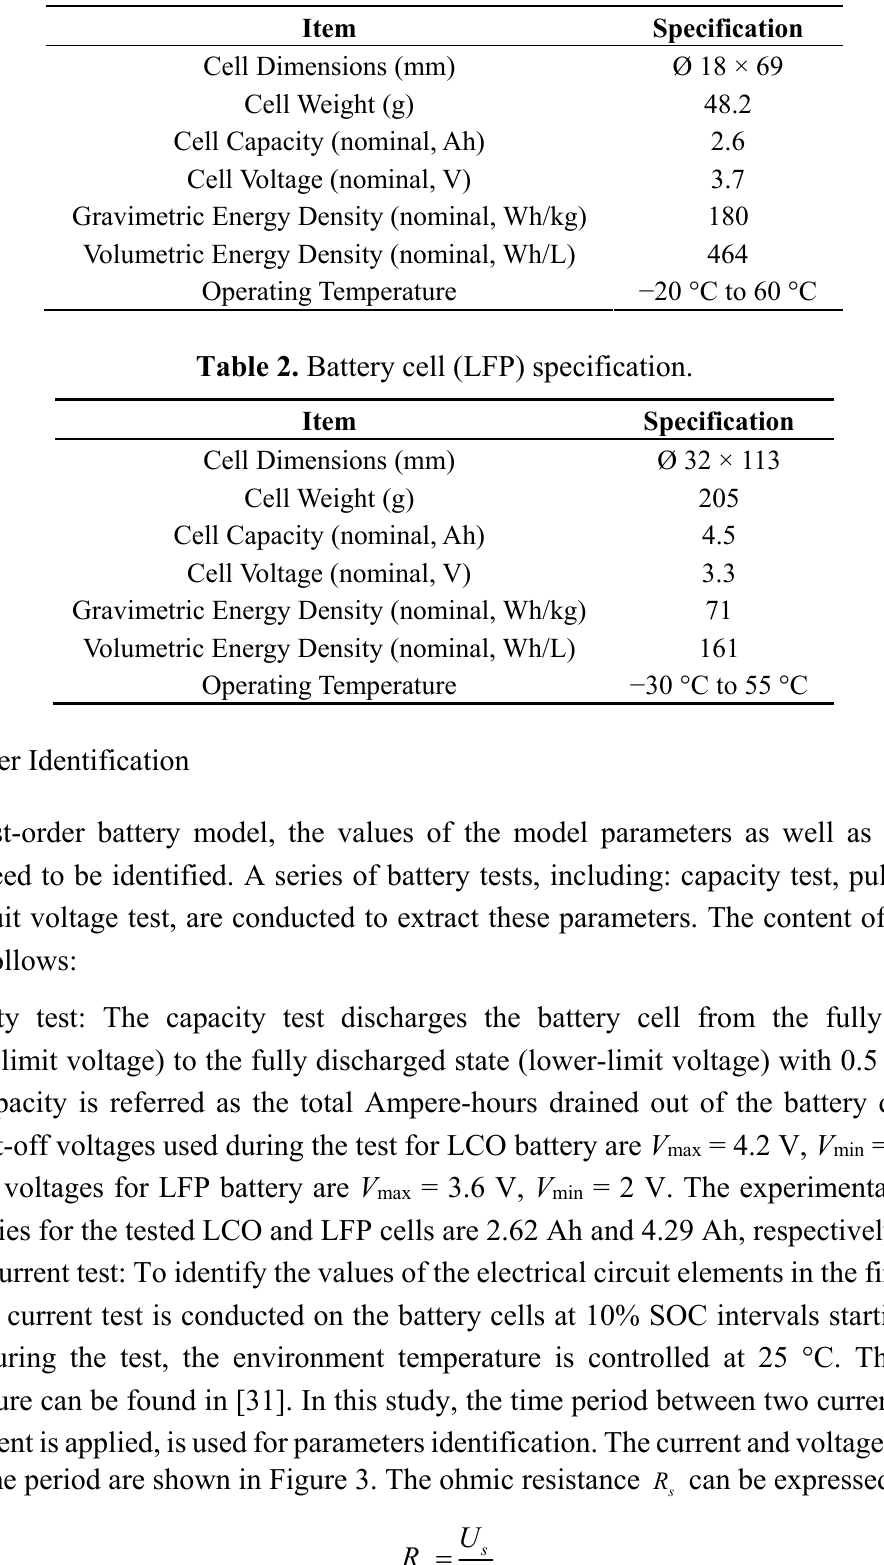
Table 1. Battery cell (LCO) specification.